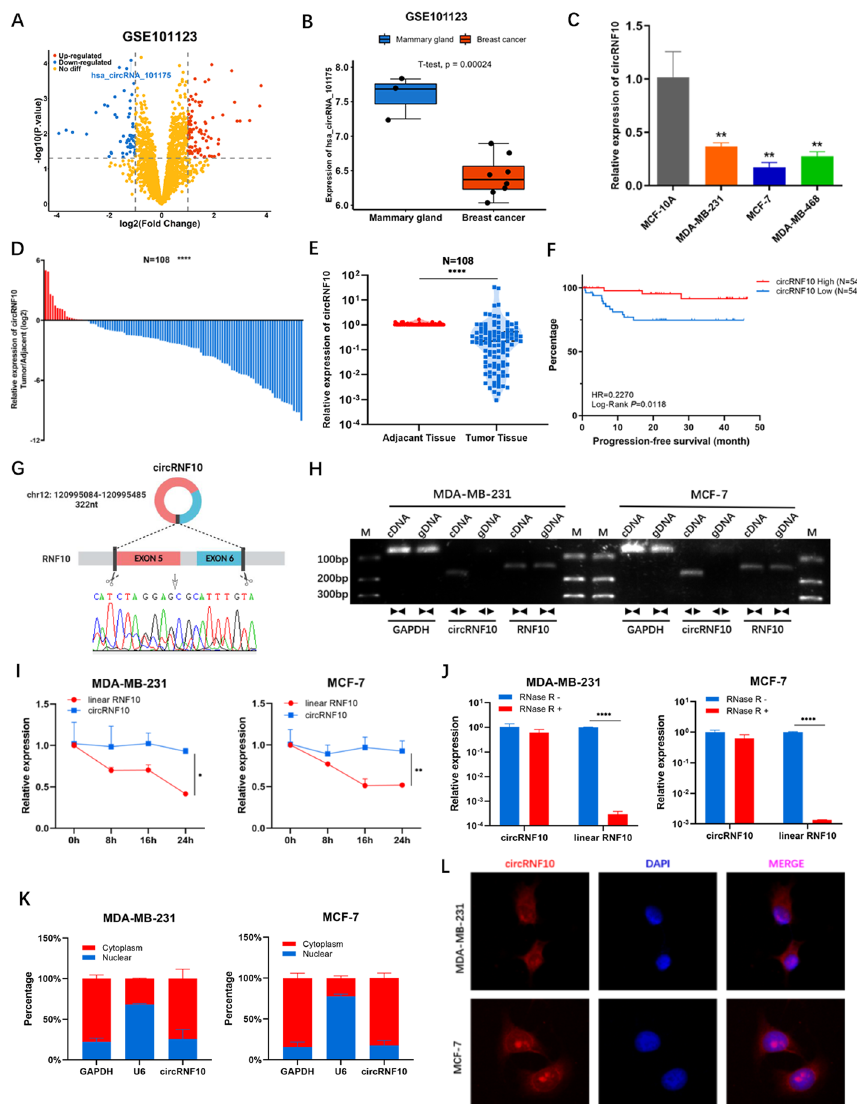
Fig. 1 The expression and characteristics of circRNF10 in BC. A Volcano plot showing the differentially expressed circRNAs in BC in GSE101123 dataset. The cutoff was set at |log 2 (fold change)| > 1 and P < 0.05. B Box plot showing the expression of circRNF10 in mammary gland and BC according to GSE101123 dataset. C RT-qPCR analysis of circRNF10 expression in BC cells compared with MCF-10A cells. D RT-qPCR analysis of circRNF10 expression in BC tissues presented as the ratio of tumor/adjacent ( N 108). E RT-qPCR analysis of = circRNF10 expression in BC tissues and adjacent tissues ( N 108). F Kaplan-Meier (K–M) plot presenting PFS = of high and low circRNF10 expression group. G The formation of circRNF10 confirmed by Sanger sequencing. H RT-PCR analysis of circRNF10 and linear RNF10 with divergent and convergent primers in MDA-MB-231 and MCF-7 cells. I The expression of circRNF10 after actinomycin D treatment in MDA-MB-231 and MCF-7 cells. J The expression of circRNF10 after RNase R treatment in MDA-MB-231 and MCF-7 cells. K Subcellular fractionation analysis of circRNF10, with U6 and GAPDH as enteral control of the nucleus and cytoplasm. L FISH analysis of circRNF10 localization in MDA-MB-231 and MCF-7 cells. Red: circRNF10, blue: DAPI. Error bars represent the means SD. * P < 0.05, ** P < 0.01, *** P < 0.001, **** P < ± suggested that knocking down of circRNF10 promoted cell viability, proliferation, clo- nogenicity, and migration of BC cells, while overexpressing circRNF10 showed the con- trary effects (Fig. 2C–J and Additional file 2: Fig. S1B–D). Considering that circRNF10